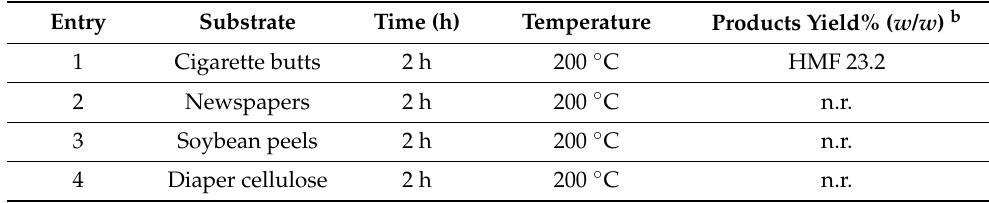
Table 5. Hydrothermal conversion of matrices in HMF catalyzed by Sc(OTf) 3 a .